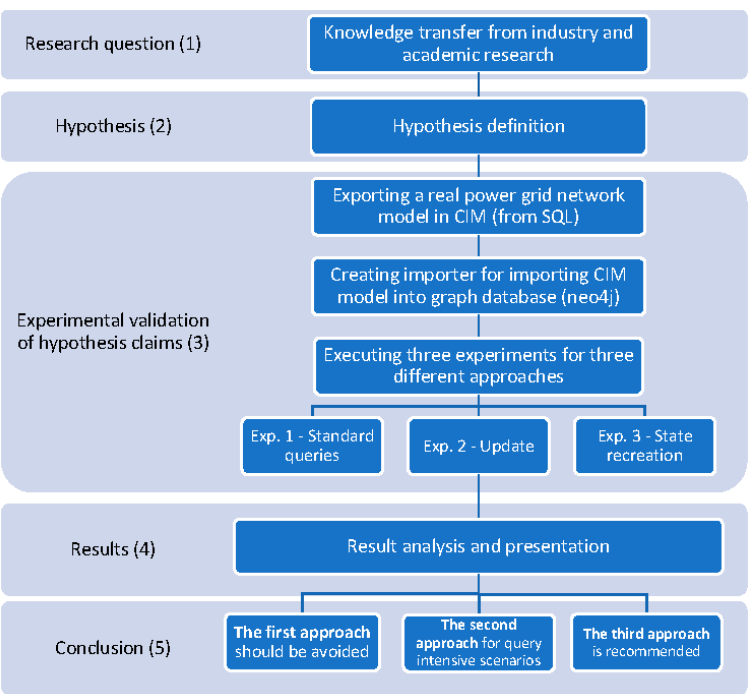
Figure 2. Flow chart of the study.